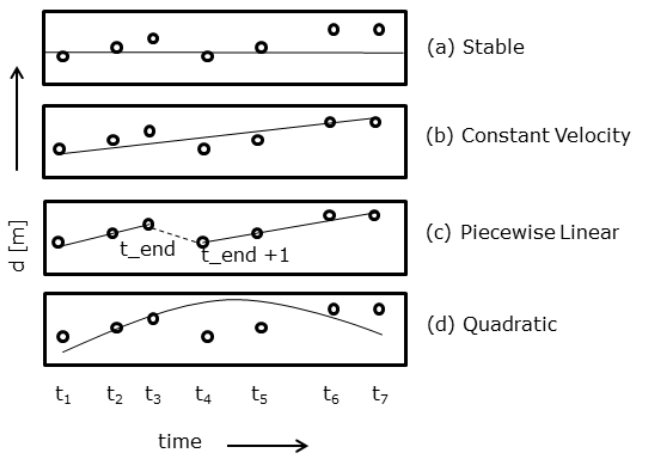
Figure 3. Temporal seafloor characterisations (updated from